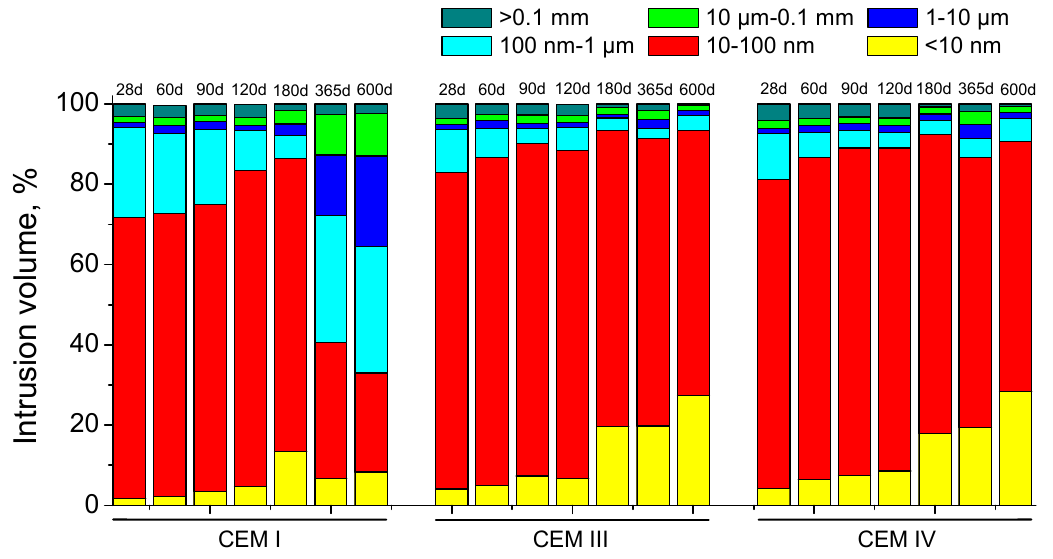
Figure 8. Pore size distributions (in percentage) for CEM I, III and IV grouts.